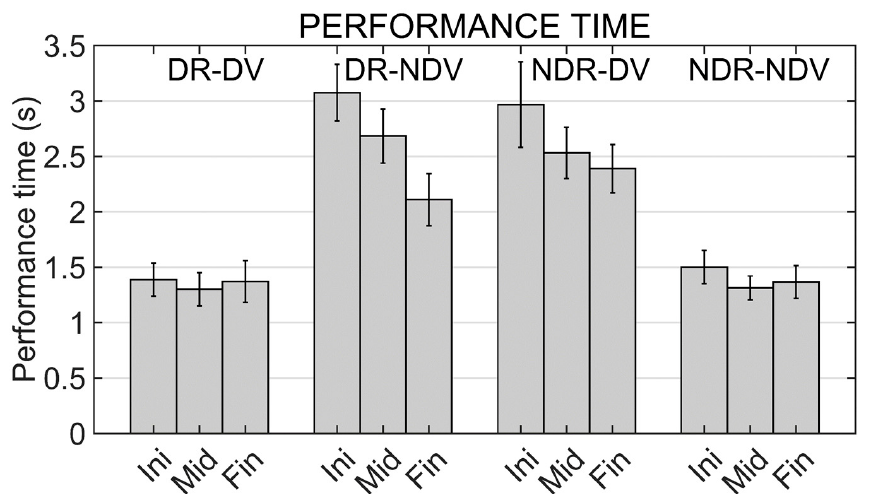
Figure 5. Performance times in the different experimental conditions (DR_DV, DR_NDV, NDR_DV and NDR_NDV) and in the different moments of the training (Initial, Middle and Final moments). Mean values and standard errors of the mean are shown.